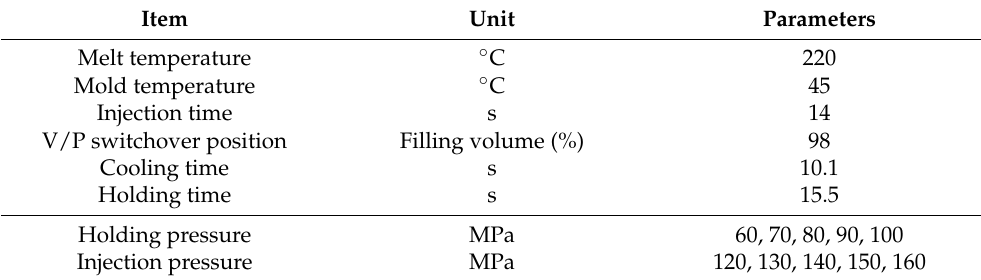
Table 3. Bumper injection molding process